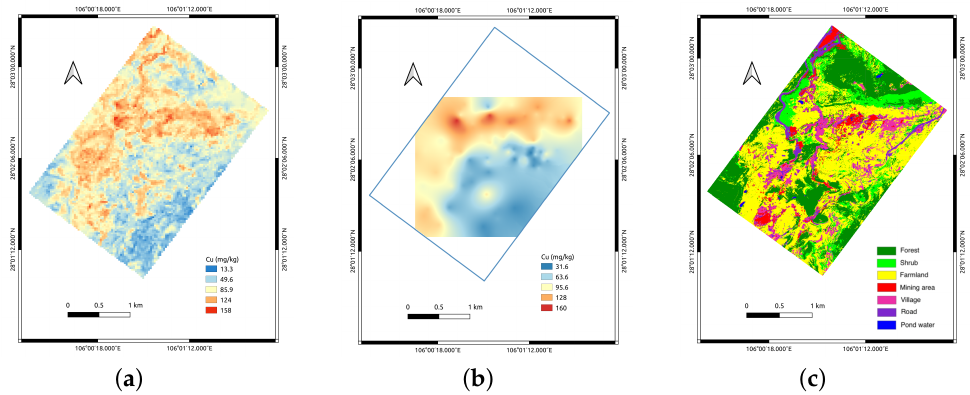
Figure 7. Cu concentration mapping and evaluation: ( a ) the distribution map of Cu concentration generated by trained SVR model; ( b ) the distribution map of Cu concentration obtained by E-kriging interpolation; ( c ) the classification map of the study